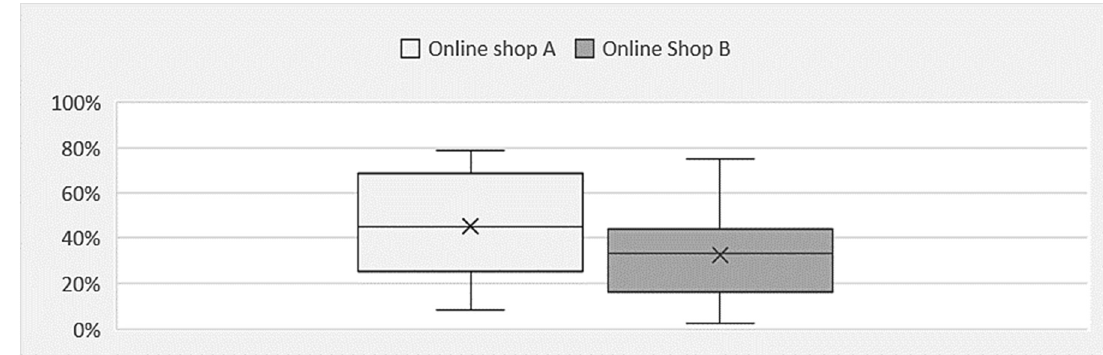
Figure 3. Proportion (in percent) of AOIs (product depictions) participants looked at.